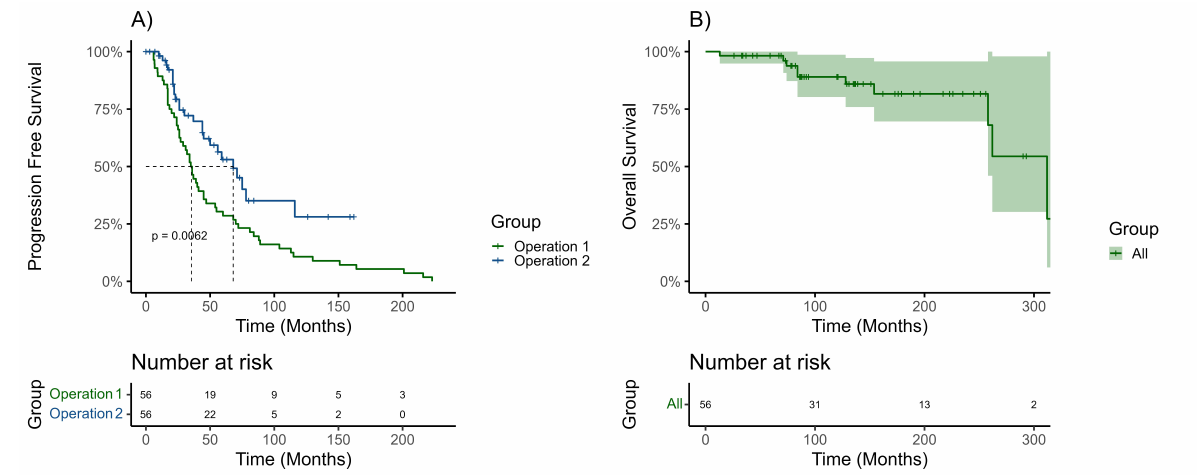
Figure 4. Kaplan Meier graphs demonstrating progression free survival with a log rank test between operation one and operation two ( A ); percentage at risk table is provided. Overall survival is demonstrated along with 95% confidence intervals ( B ). Censoring on both graphs is demonstrated by crosses on the